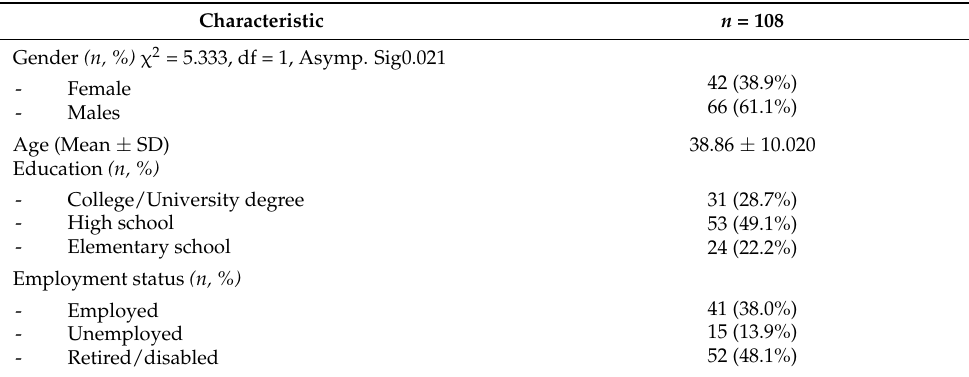
Table 1. Sociodemographic and clinical characteristic of PS